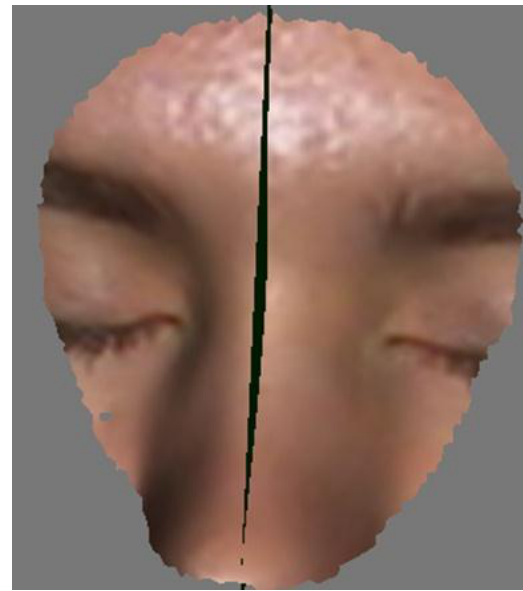
Figure 10. Sample of plane constructed by the